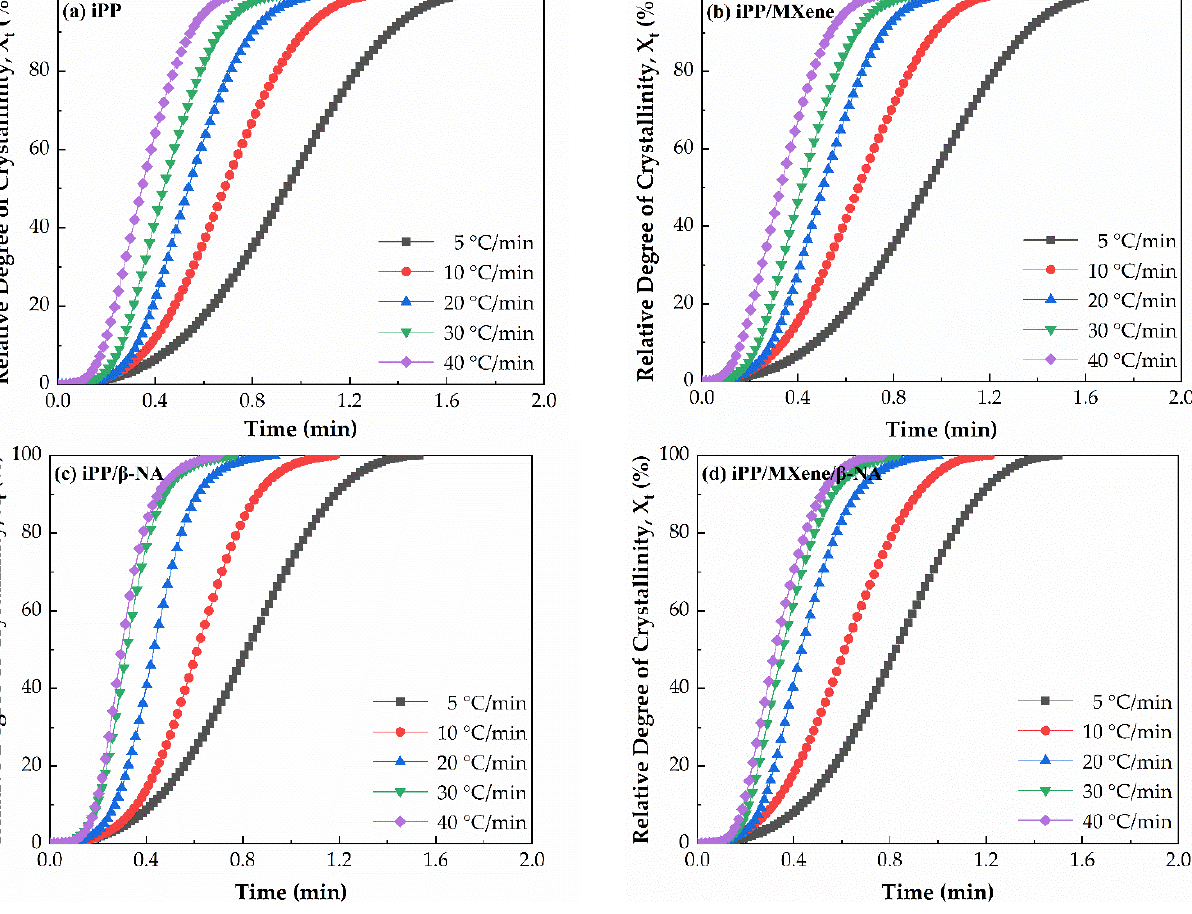
Figure 6. Plots of relative degree of crystallinity as a function of time of ( a ) iPP, ( b ) iPP/MXene, ( c ) iPP/ β -NA, and ( d ) iPP/MXene/ β -NA at different cooling rates.